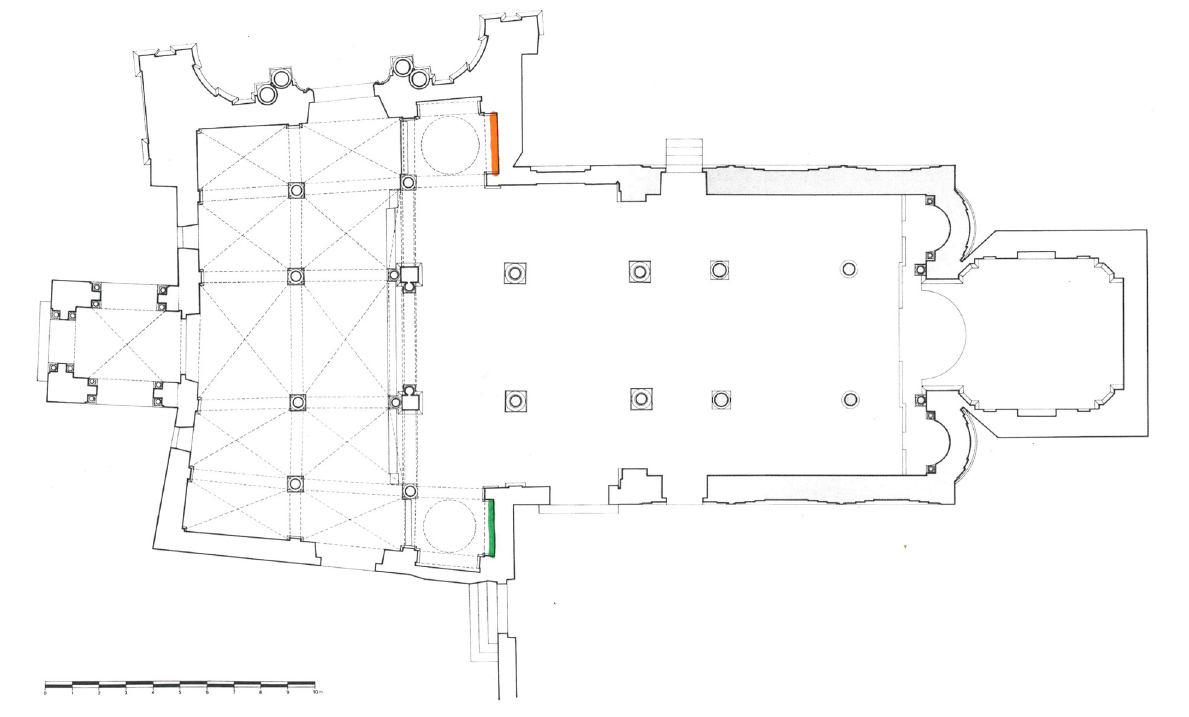
Figure 3: Palermo, St. Mary of the Admiral, plan of the actualchurch. Green line: position of the Coronation panel; orange line: position of the Dedication panel (authors modified after Ćurčić in Kitzinger, 1990, Pl. A